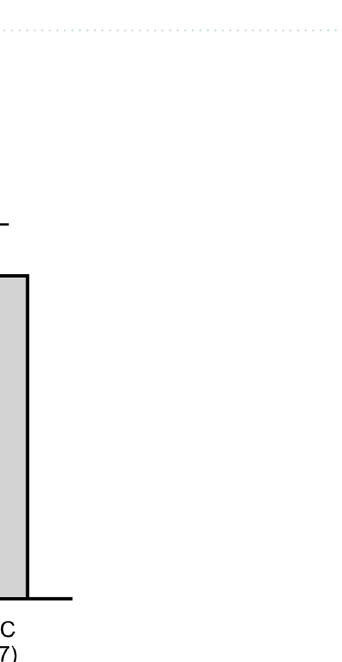
Figure 5. Findings in urinary bladder in cases of neurogenic bladder dysfunction. ( A ) Transmission electron microgram shows TC with its nucleus (n) and short thin cytoplasmic extension of Tp (red triangle). ( B ) Digitalized image of ultrastructural findings in neurogenic bladder dysfunction shows TC with its nucleus (n), Tp (red arrows) having many vesicles. Telopodes appeared in close contact to smooth muscle cells (SMC) and excess collagen. (Scale bar 2 μm).